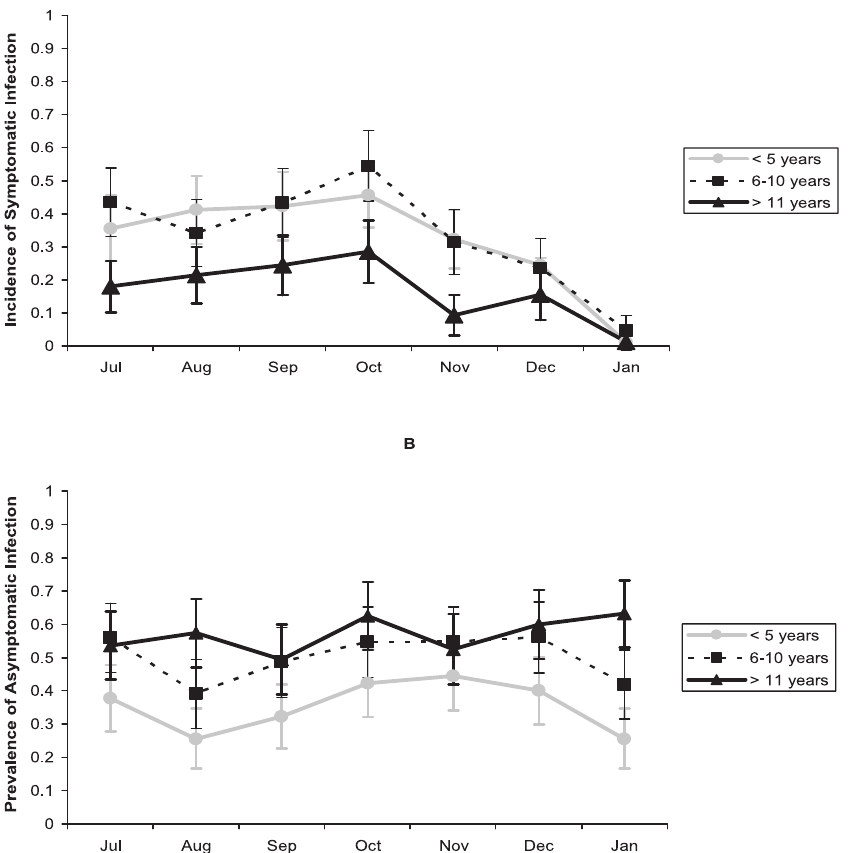
Figure 4. Frequency of Symptomatic and Asymptomatic Infections during the Malaria Transmission Season in Three Age Groups (A) Incidence of symptomatic infection over the course of the transmission season. (B) Prevalence of parasitemia among asymptomatic monthly surveys. Values in the figure represent the average for all three years of the study, since patterns were similar in all years. Bars indicate 95% CIs.